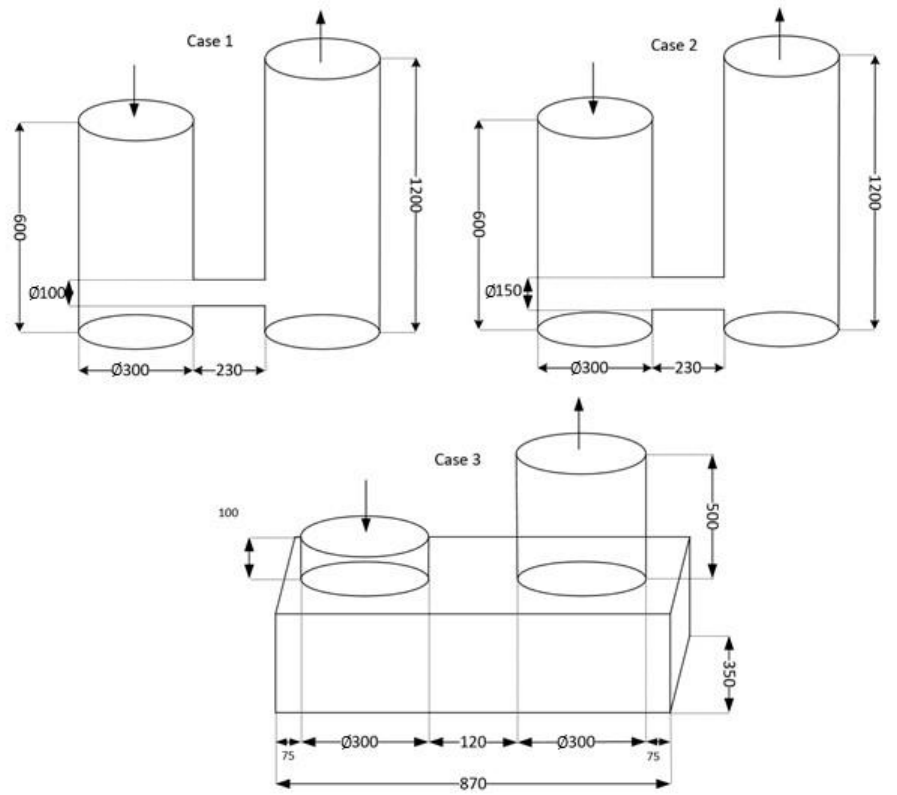
Figure 1. Flow geometry outlines for the CFD case studies (the diameters of both columns for all cases were 300 mm).